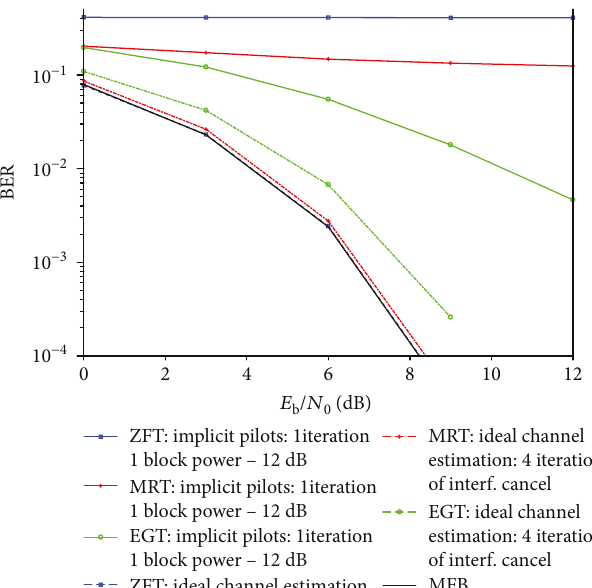
Figure 7: BER results with 32 × 2 using implicit pilots with 1 data block, 1 iteration, and a pilot power of − 12dB.